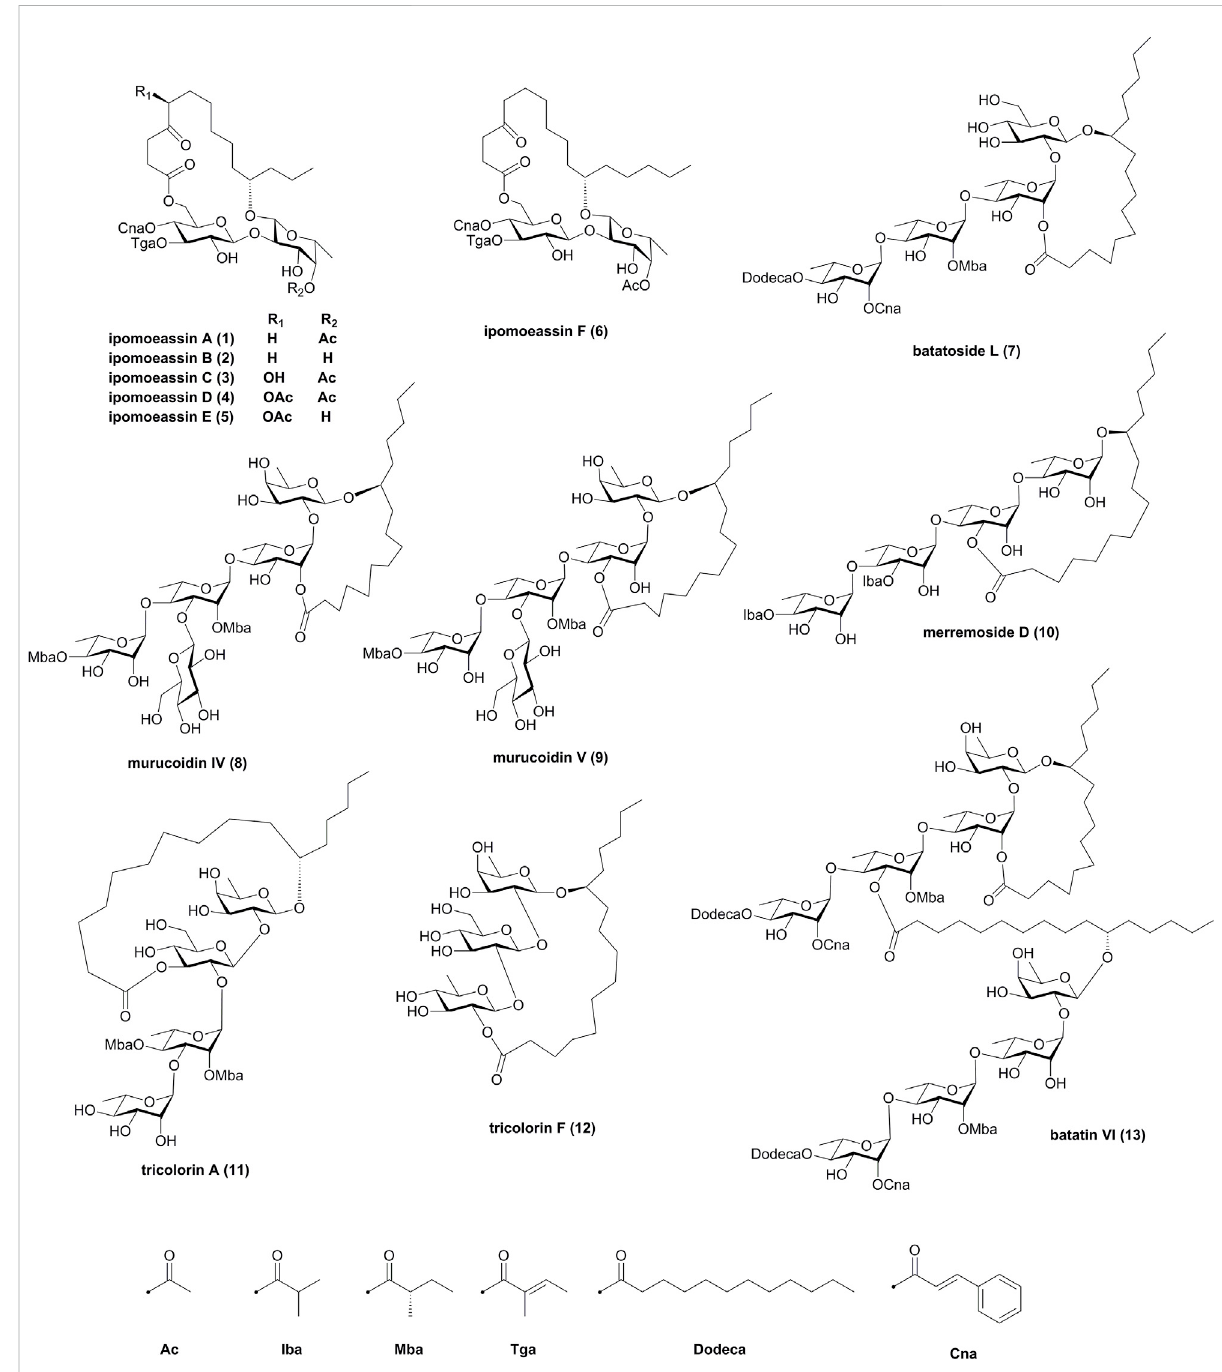
FIGURE 1 Structures of resin glycosides 1 – 13 . Iba, isobutyryl; Mba, 2 S -methylbutyryl; Tga, tiglyl; Dodeca, n-dodecanoyl; Cna, trans